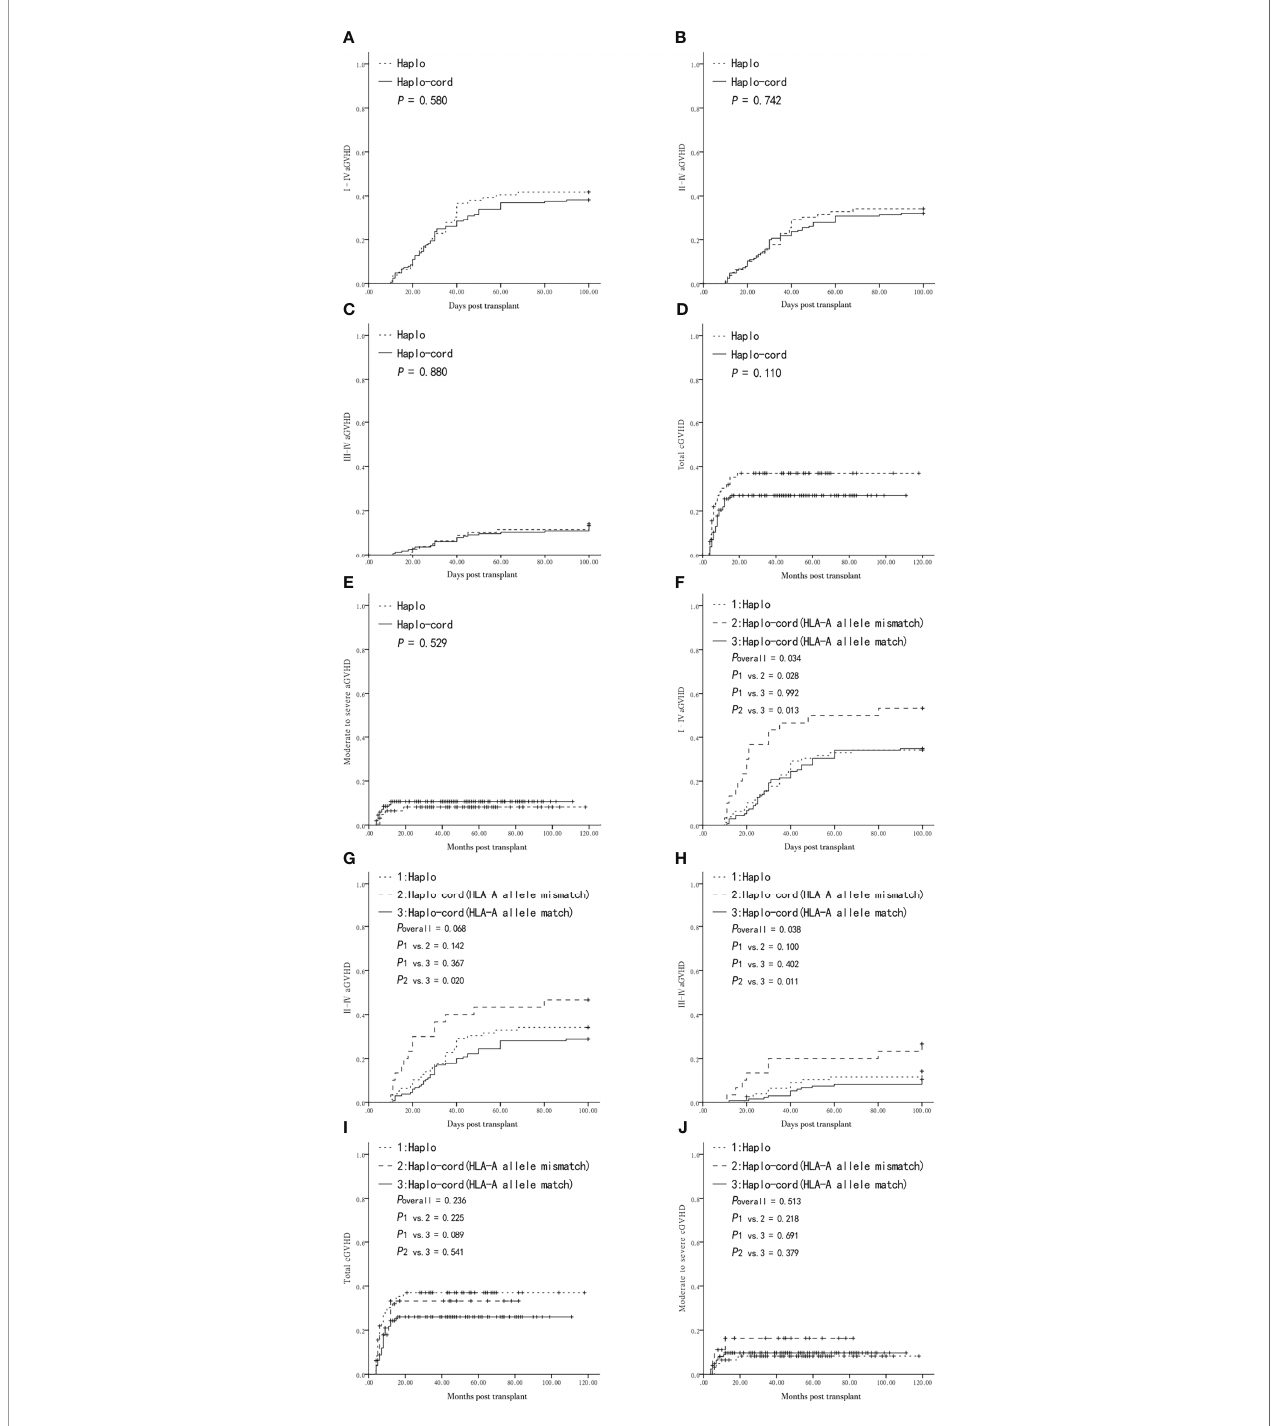
FIGURE 1 | Graft-versus-host-disease (GVHD) after transplantation from Haplo-HSCT or Haplo-cord-HSCT (including subgroups). (A) Grade I – IV acute GVHD (aGVHD) between Haplo-HSCT and Haplo-cord-HSCT group. (B) Grade II – IV aGVHD between the two groups. (C) Grade III – IV aGVHD between the two groups. (D) Total chronic GVHD (cGVHD) between the two groups. (E) Moderate to severe cGVHD between the two groups. (F) Grade I – IV aGVHD among Haplo-HSCT group and Haplo-cord with a HLA-A match or mismatch subgroups. (G) Grade II – IV aGVHD among Haplo-HSCT group and Haplo-cord with a HLA-A match or mismatch subgroups. (H) Grade III – IV aGVHD among Haplo-HSCT group and Haplo-cord with a HLA-A match or mismatch subgroups. (I) Total cGVHD among Haplo-HSCT group and Haplo-cord with a HLA-A match or mismatch subgroups. (J) Moderate to severe cGVHD among Haplo-HSCT group and Haplo-cord with a HLA-A match or mismatch